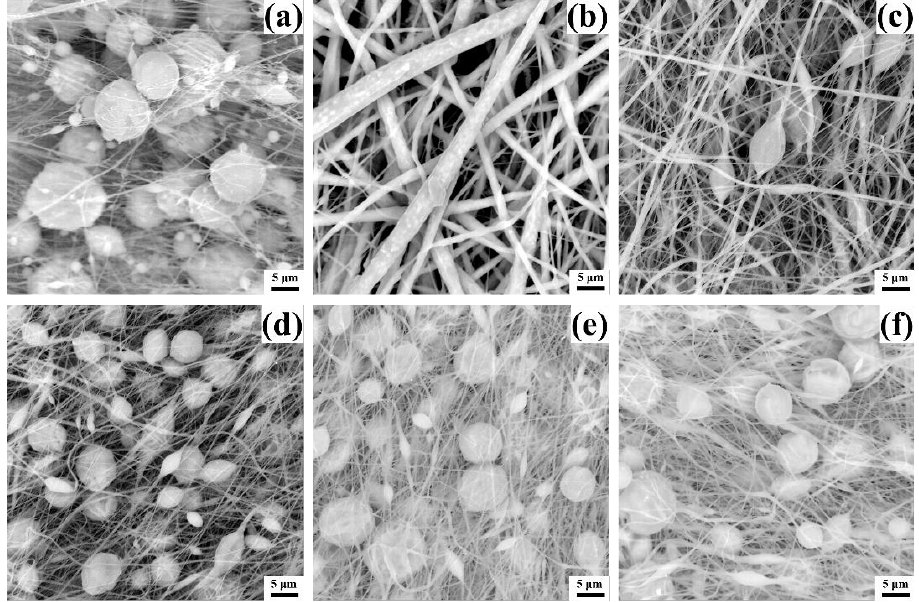
Figure 2. SEM images of different PVDF/PDMS electrospun membranes. ( a ) Micromorphology of P0. ( b ) Micromorphology of P1. ( c ) Micromorphology of P2. ( d ) Micromorphology of P3. ( e ) Micro- morphology of P4. ( f ) Micromorphology of P5.